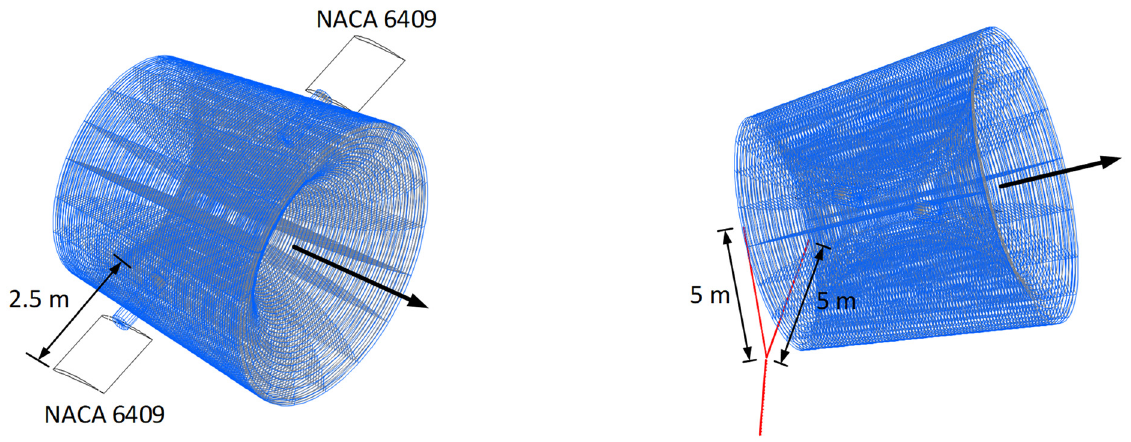
Figure 11. Duct model in OrcaFlex.